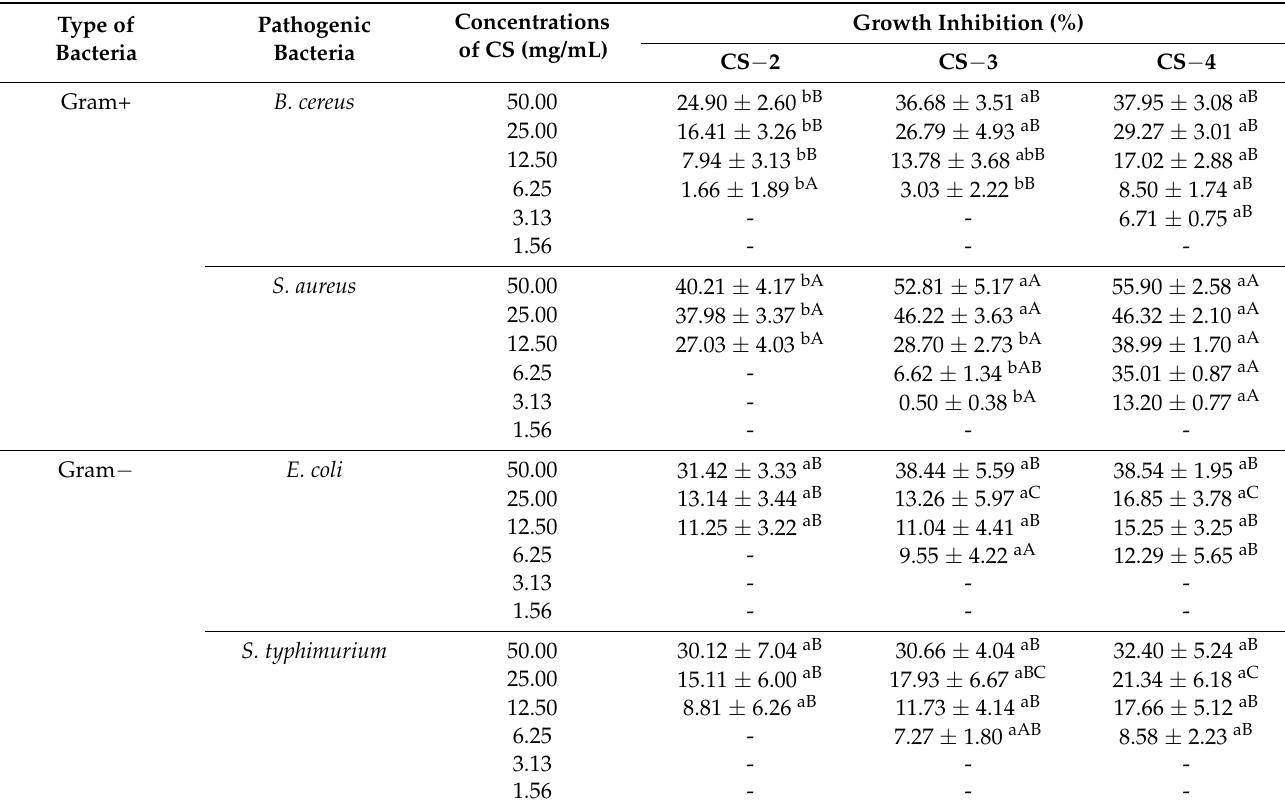
Table 2. Antimicrobial activity of CS with different deacetylation times against different pathogenic bacteria by broth-dilution